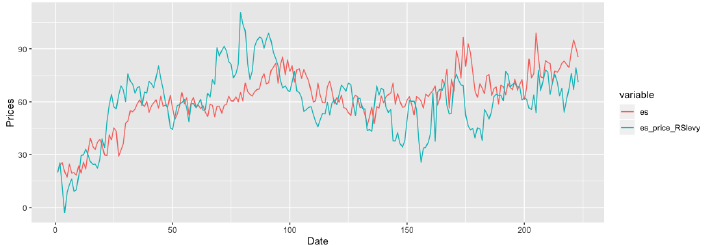
Figure 12. Simulation Result of RSLDOU model on energy-switching data. To see the probabilities of regime one and two happened in time t, we report the smoothed and filtered probabilities for energy-switching data in Figure 13.